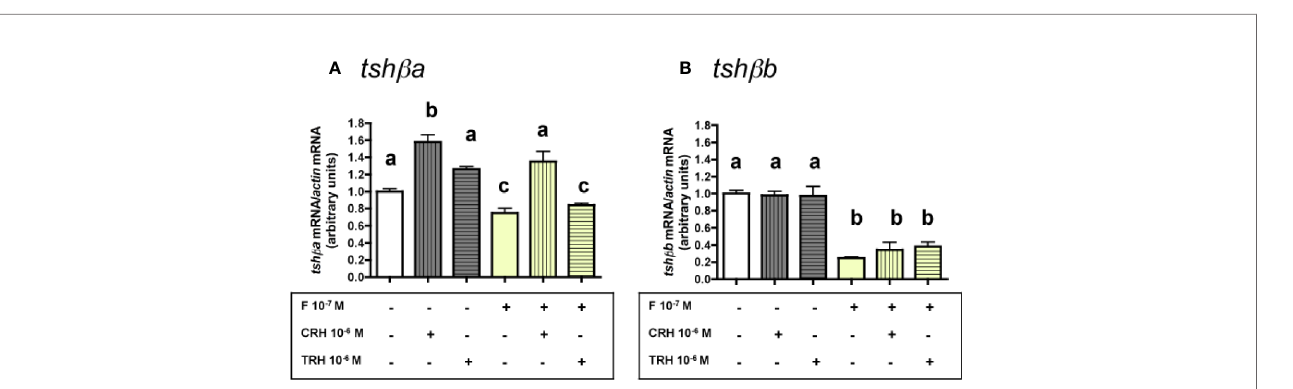
FIGURE 5 | Effects of CRH and TRH on tsh b a and tsh b b transcript levels in the presence of cortisol in primary cultures of Atlantic salmon pituitary cells. Pituitary cells from juvenile Atlantic salmons were treated for 10 days with 10 -6 M of CRH or 10 -6 M TRH in the presence of 10 -8 M of cortisol (F) and mRNA levels of tsh b a (A) and tsh b b (B) were quanti fi ed by qPCR. Data were normalized against b -actin . The Figure displays the results from a representative experiment of three independent cell culture experiments. Mean ± SEM; n = 5 well replicates. Different letters indicate signi fi cant differences,